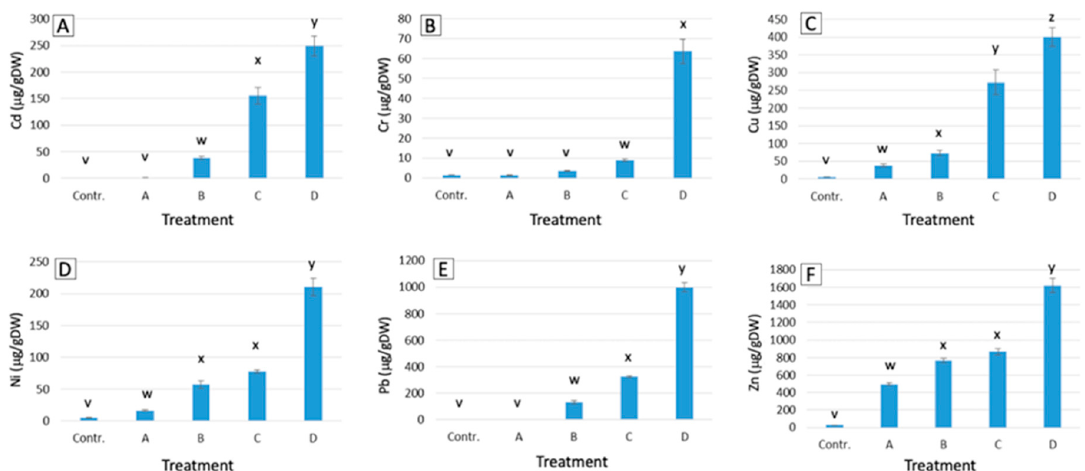
Figure 1. Metal contents in shoots of P. aviculare grown in hydroponics at increasing metal concentrations (from control to D, see Methods section) . ( A ) Cd; ( B ) Cr; ( C ) Cu; ( D ) Ni; ( E ) Pb; ( F ) Zn. Bars represent the average of data coming from five populations analyzed in three biological replicates ( n = 15). Different small letters (from v to z) above the bars indicate a statistically significant difference among the treatments ( p < 0.05 ) calculated with Dunn.test using R software.